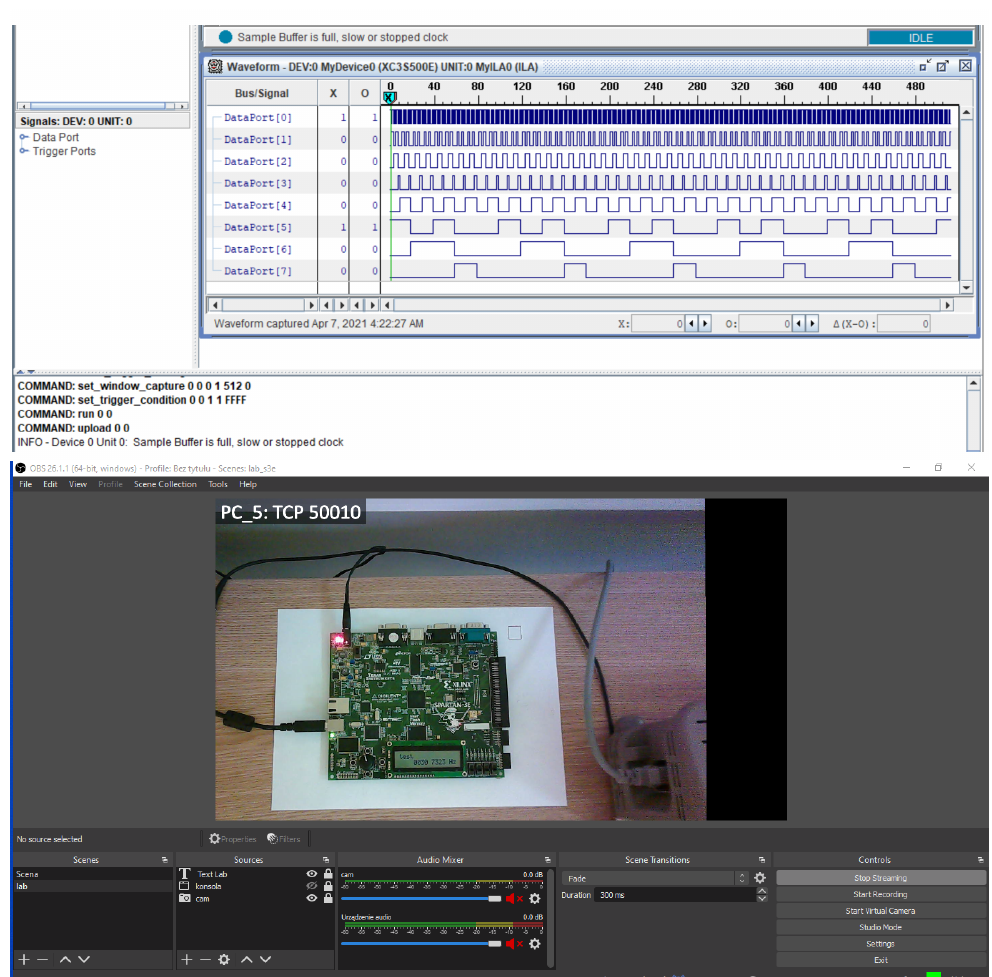
Figure 6. ( Top ) The measurement results of a counter based on a frequency divider frequency for a Spartan-3E Board. On the DataPort[0] channel, the frequency of 50 MHz is present. Subsequent channels show frequency waveforms with half the frequency of the previous channel. ( Bottom ) The Spartan 3e board configuration with a counter (based on a frequency